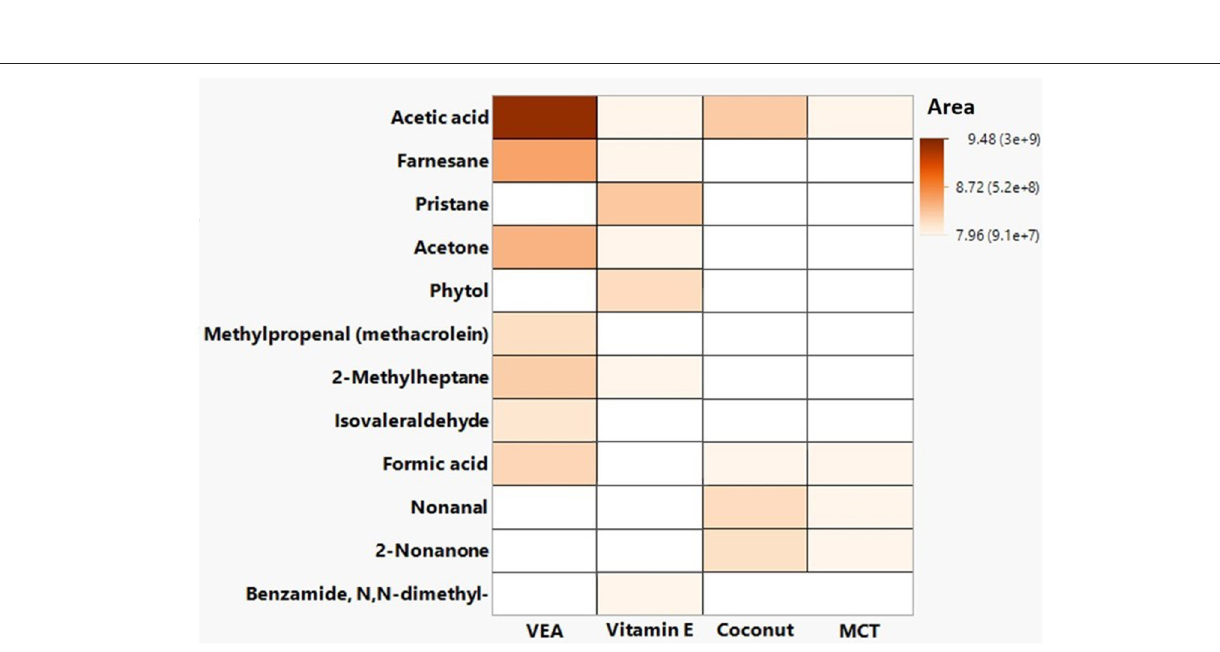
Frontiers in Public Health |